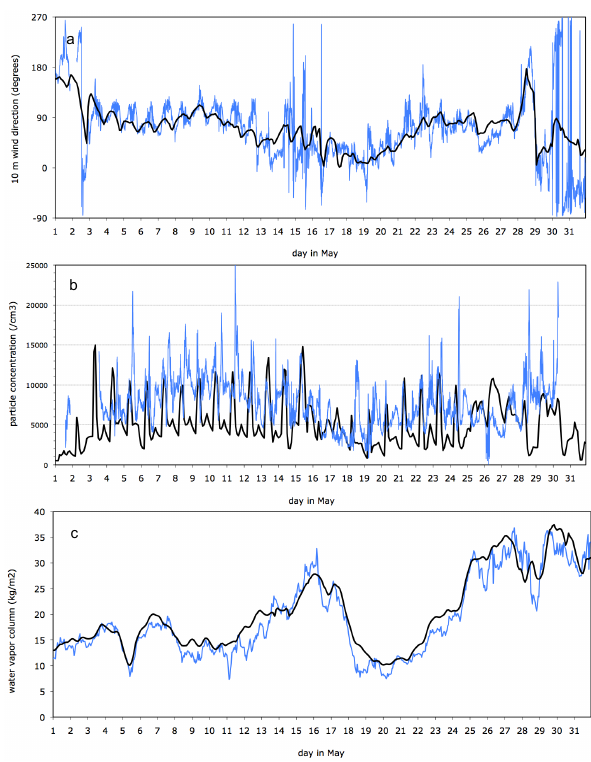
Figure 3. Observed (blue) and simulated (black) a) 10 m wind direction (degrees), b) surface Fig. 3. Observed (blue) and simulated (black) (a) 10m wind concentration of fine mode particles(< 1 µ m diameter; cm -3 ), and c) water vapor column (IWV, kg/m 2 ). direction (degrees), (b) surface concentration of fine mode particles( < 1µm diameter;cm − 3 ), and (c) water vapor column (IWV, kg/m 2 ).